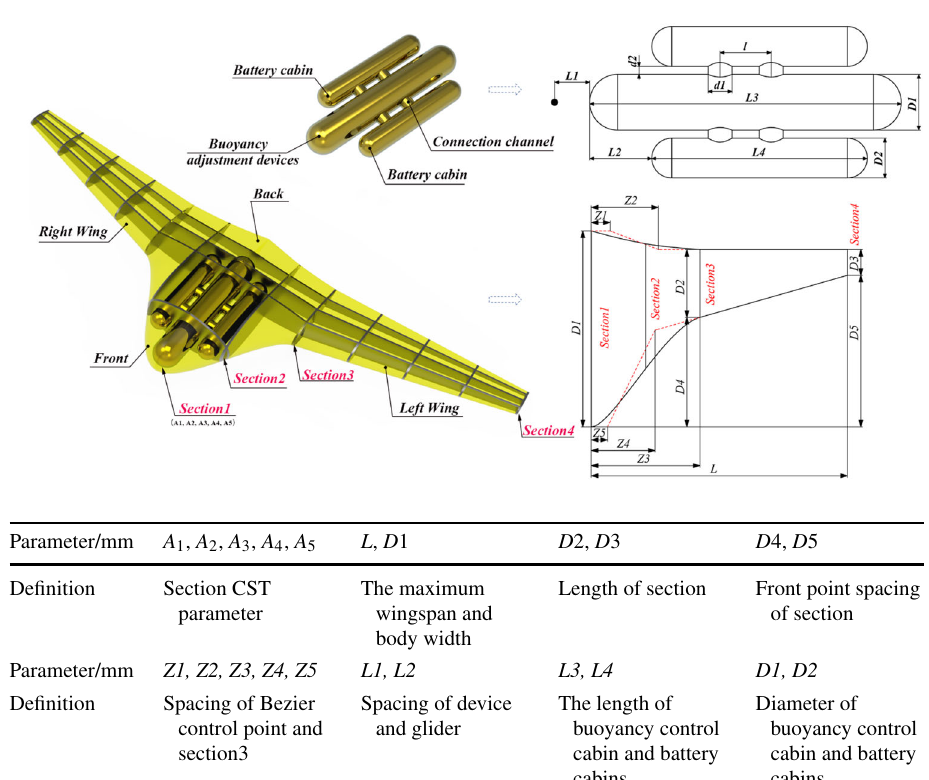
Table 9 Parameter definition of